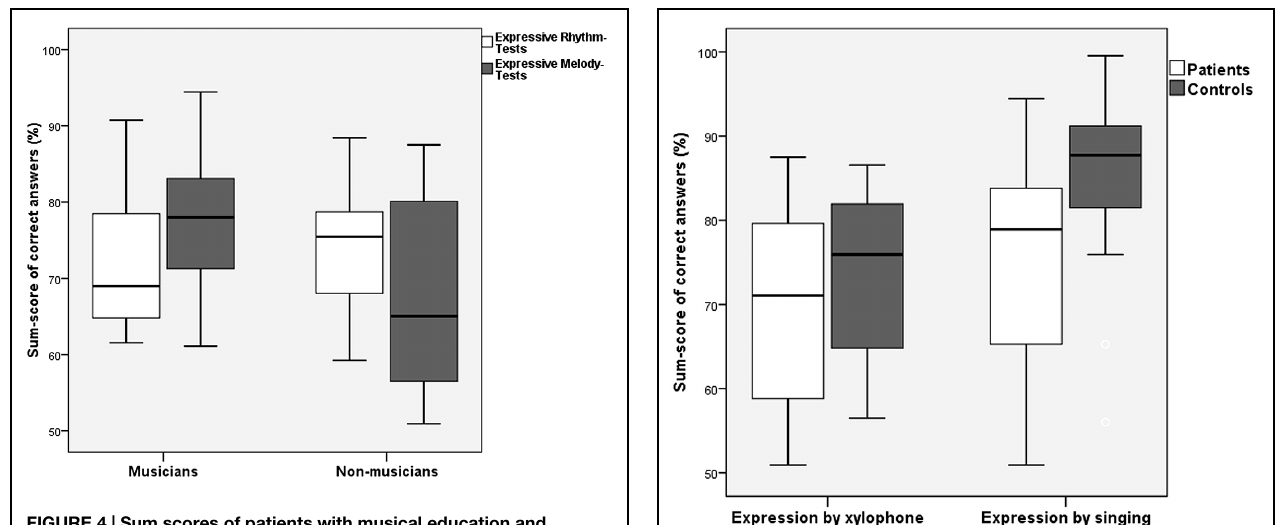
FIGURE 4 | Sum scores of patients with musical education and patients without for Expressive Rhythm Tests vs. Expressive Melody Tests (error bars indicate one standard deviation). FIGURE 5 | Sum scores of patients and controls for expressive